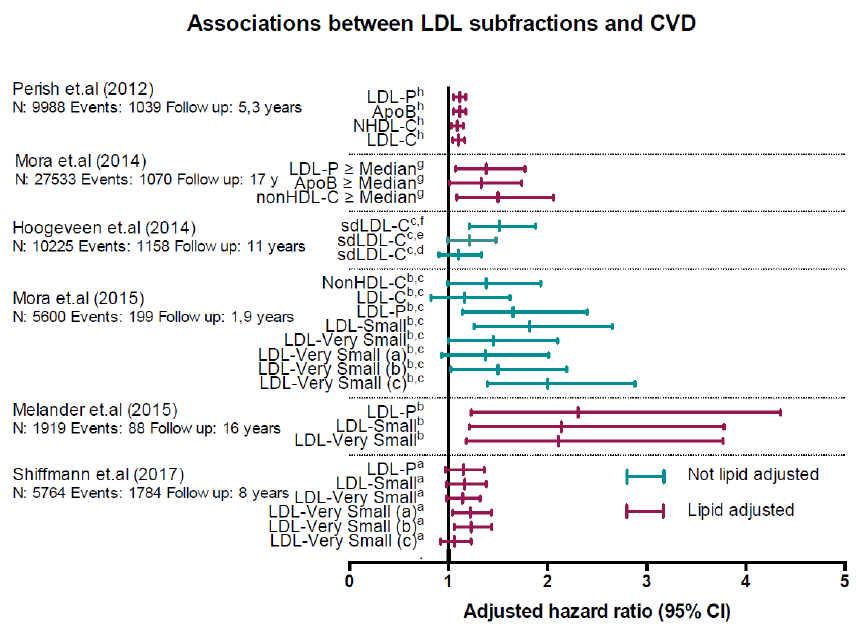
Figure 2. Associations between low-density lipoprotein (LDL) subfractions and cardiovascular disease (CVD) reported in prospective population-based studies published after 2009 and adjusted for confounding factors, such as age, smoking, gender, hypertension, etc. a Top vs. bottom quartile analysis. b Top vs. bottom tertile analysis. c Not significant in a model adjusted for lipids. d 1st vs. 2nd quartile analysis. e 1st vs. 3rd quartile analysis. f 1st vs. 4th quartile analysis. g Associations with CVD in patients with discordant levels of LDL particle number (LDL-P), apolipoprotein B (apoB), non-high density lipoprotein cholesterol (non-HDL-C) ( ≥ median), and LDL cholesterol (LDL-C) (<median). h Hazard ratio (95% CI) pr. 1 SD higher. Hazard ratios for the outcome “major occlusive event” in